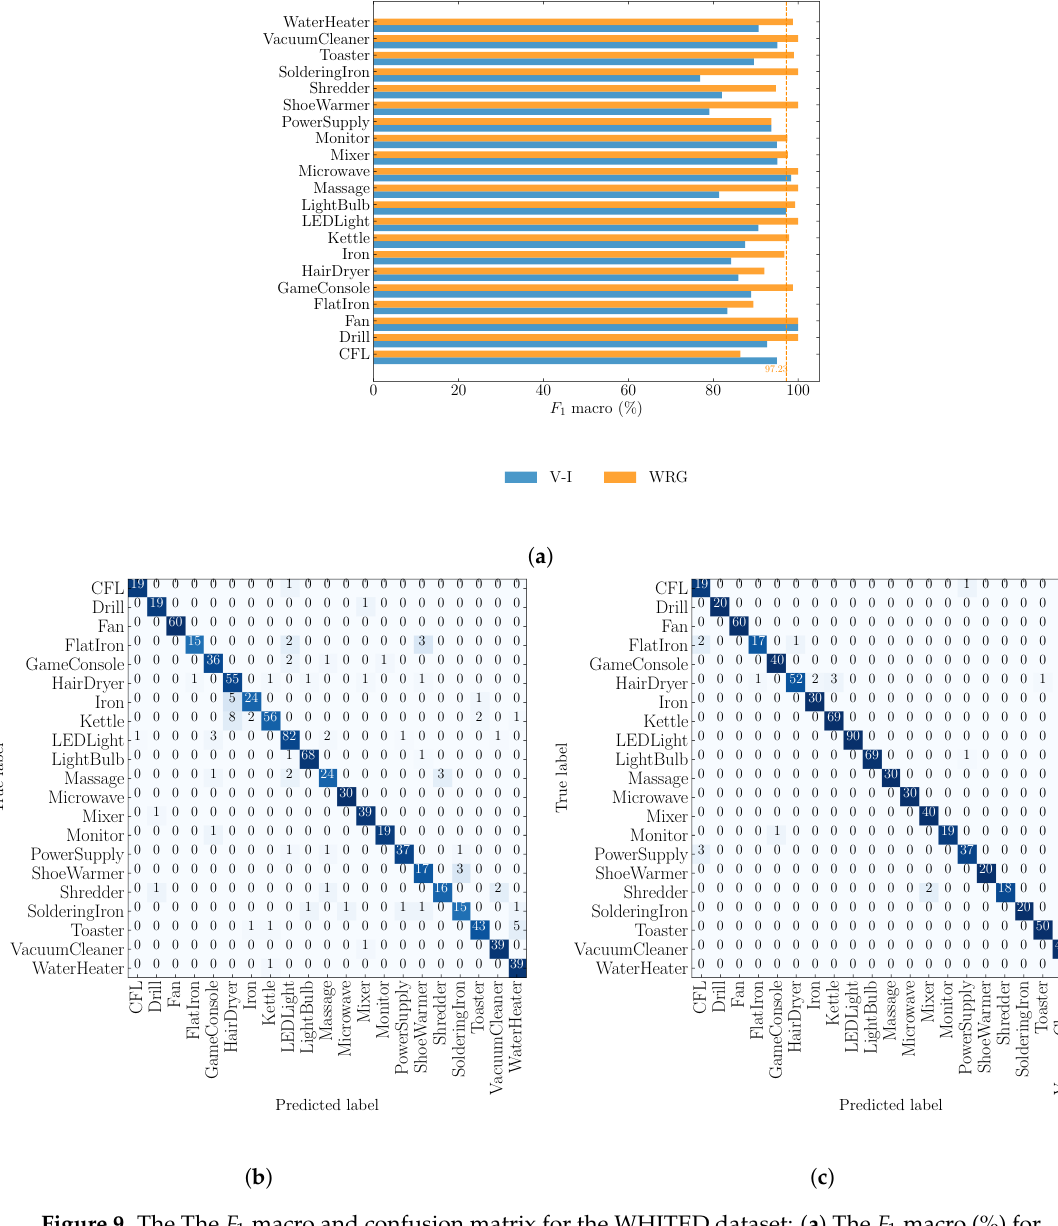
Figure 9. The The F 1 macro and confusion matrix for the WHITED dataset: ( a ) The F 1 macro (%) for the WHITED dataset with V–I and WRG feature representation; ( b ) WRG confusion